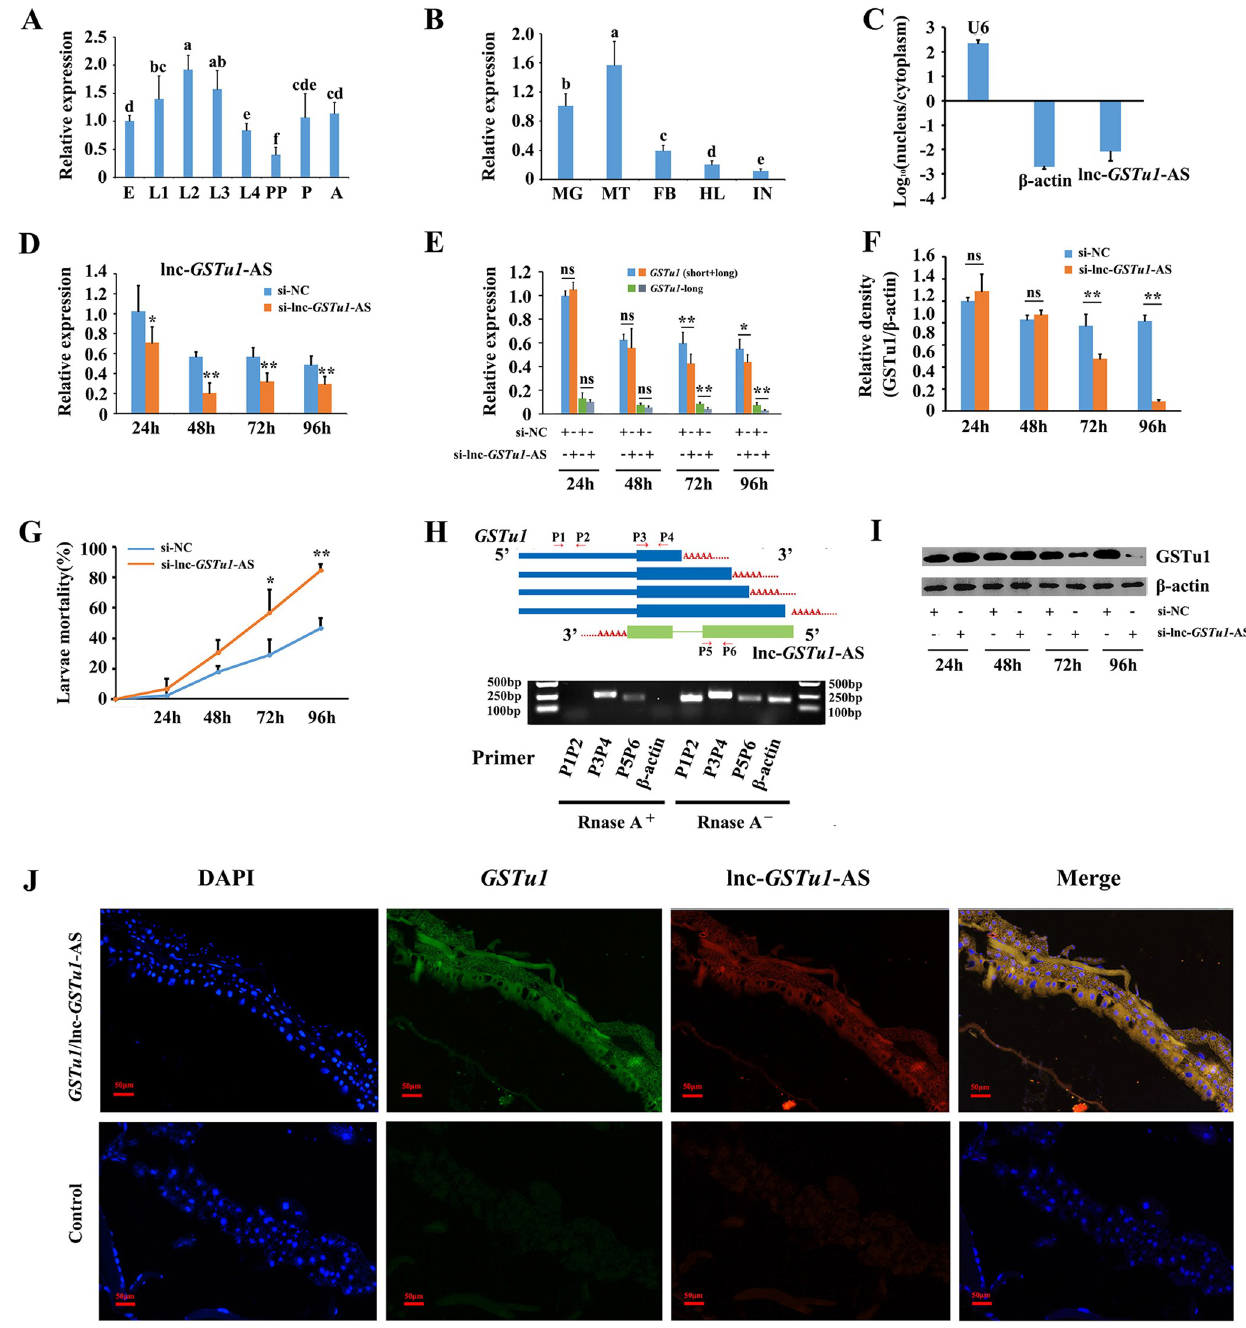
Fig 4. Lnc- GSTu1 -AS is involved in the regulation of chlorantraniliprole resistance. Relative expression of lnc- GSTu1 -AS at different developmental stages (A), in different tissues (B), in nuclear RNA and cytoplasmic RNA (C), and in control and lnc- GSTu1 -AS knockdown groups (D) of P . xylostella . Relative expression of GSTu1 in the control and lnc- GSTu1 -AS knockdown groups by qRT-PCR (E) and Western blot (F, I). G: Mortality of P . xylostella treated with the LC 50 of chlorantraniliprole. H: Analysis of the binding relationship between lnc- GSTu1 -AS and GSTu1 -3 0 UTR by ribonuclease protection assays (RPA). J: Co-localization of lnc- GSTu1 -AS and GSTu1 in the midgut of P . xylostella by fluorescence in situ hybridization (FISH) assay. Asterisks indicate significant differences between the treatment and the corresponding control (Student’s t -test, � 0.01 < P < 0.05, �� P < 0.01). Different lowercase letters represent significant differences (one-way ANOVA followed by Tukey’s multiple comparison tests, P < 0.05).